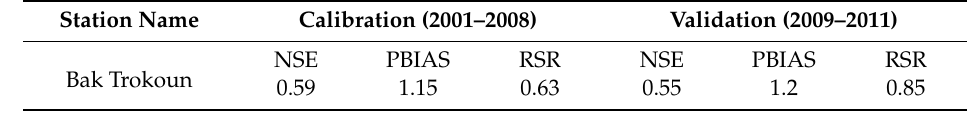
Table 3. Calibration and validation performance for monthly time-step streamflow simulations at the PRB showing the Nash-Sutcli ff e e ffi ciency (NSE), percent bias (PBIAS), root mean squared error observations standard deviation ratio (RSR).